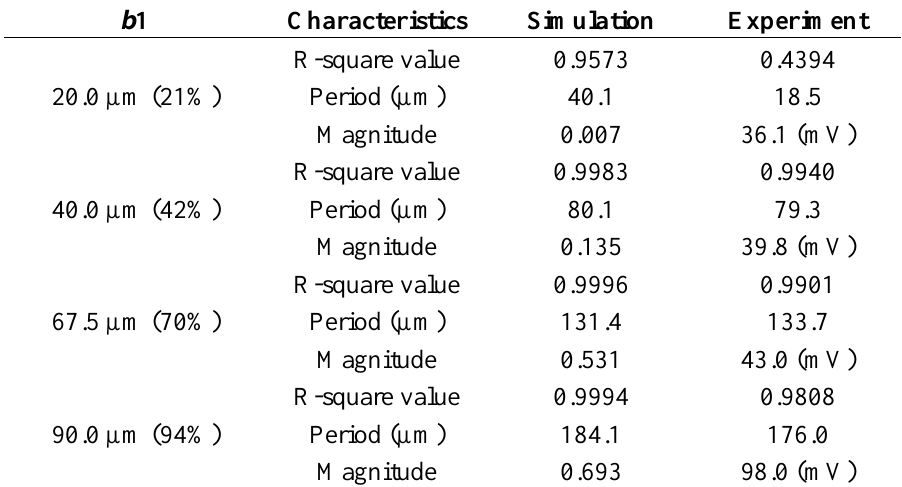
Table 3. Comparison of the results between the simulation and experiment. b